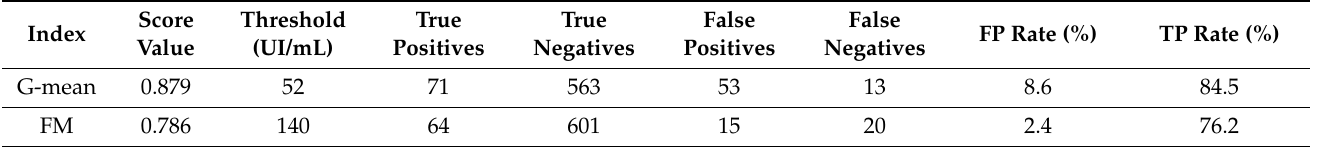
Table 1. Details of the ROC curve thresholds given by the different types of scores. G-mean stands for geometric mean and FM for the Fowlkes–Mallows index. These two indexes can yield a score between 0 and 1. The optimum values obtained are indicated in the score value column, together with the corresponding threshold detection for the NeuMoDx™ measurements, the number of true positives, true negatives, false positives, false negatives, and the rate of false positives (FP rate) and of true positives (TP